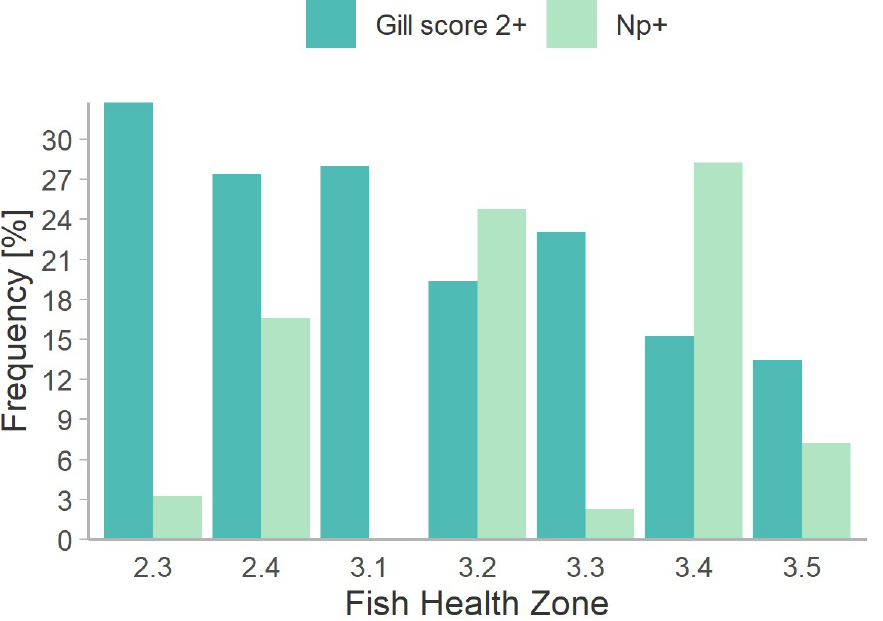
Figure 1. Proportions of farmed Atlantic salmon with visual gill scores ≥ 2 (n = 1898) or qPCR-detected Neoparamoeba perurans (n = 1925), from DFO-FHAIP data in British Columbia. All data summarised by health management zone from 2016 to 2020.